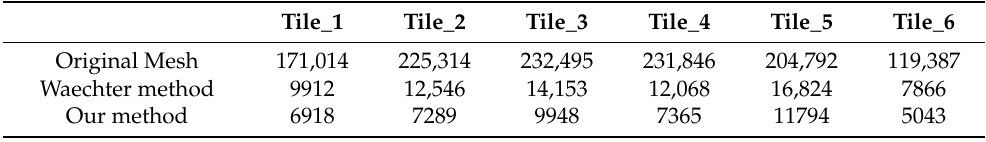
Table 3. Comparison of the number of texture charts using the two methods for texture reconstruction in the building experimental areas.